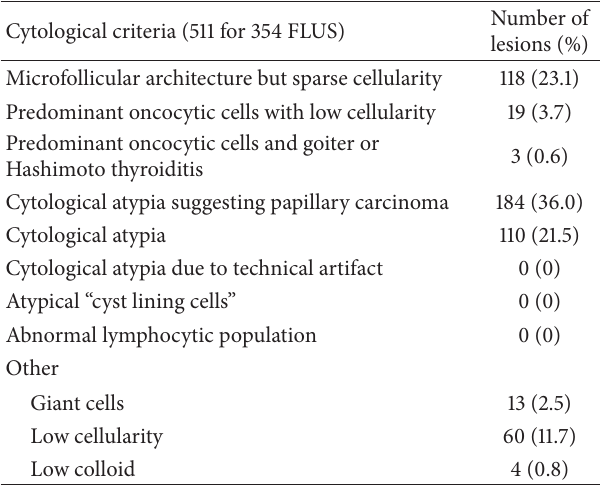
Table 3: Distribution of FLUS criteria in our series.